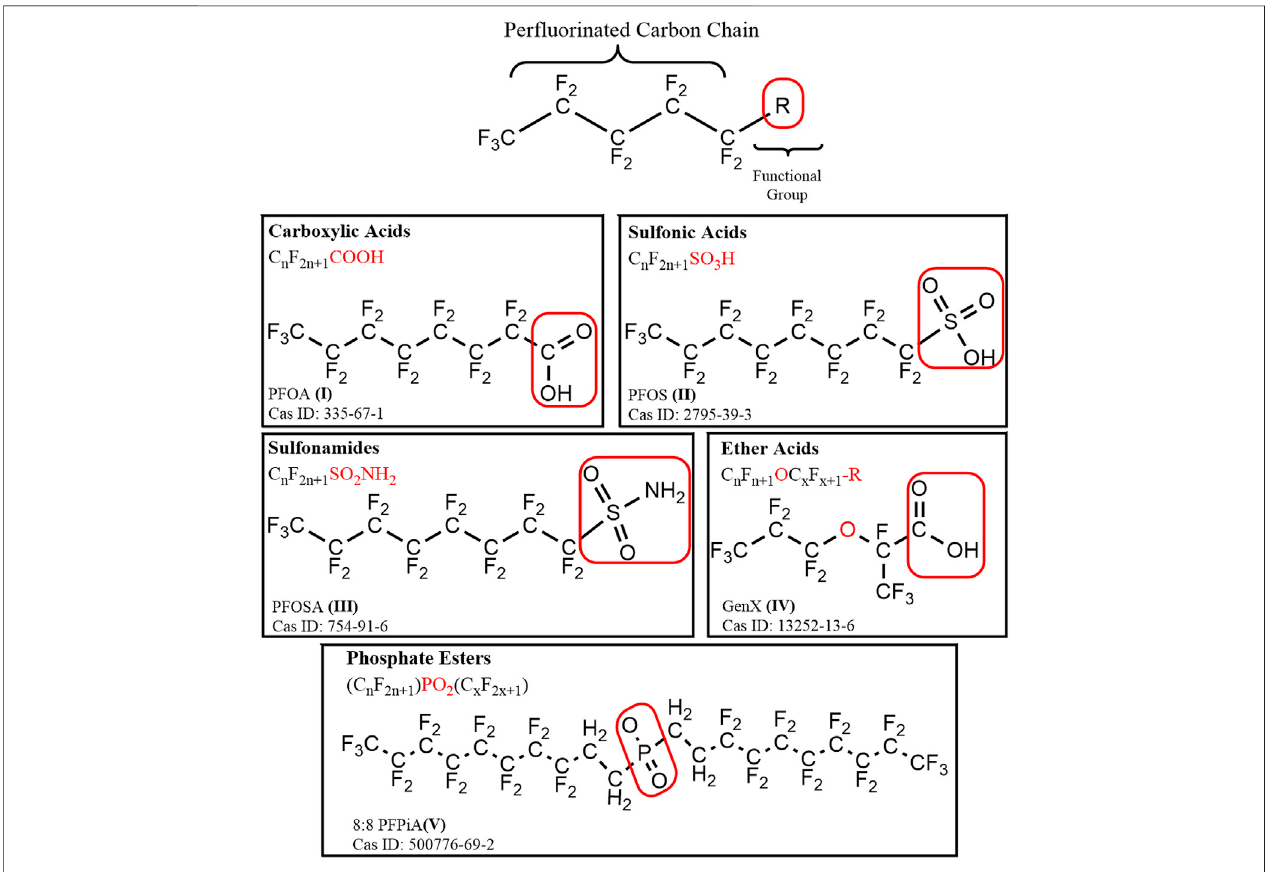
FIGURE1| Ageneralstructuralformulaforper fl uoroalkylsubstance(PFAS),containingahydrophobicper fl uorinatedalkyltail,andahydrophilicfunctional(R)group outlined inared box. Examplecompounds aredepictedfor each ofthe majorchemical classesofPFAS discussed: carboxylic acids, sulfonic acids, sulfonamides, ether acids, and phosphate